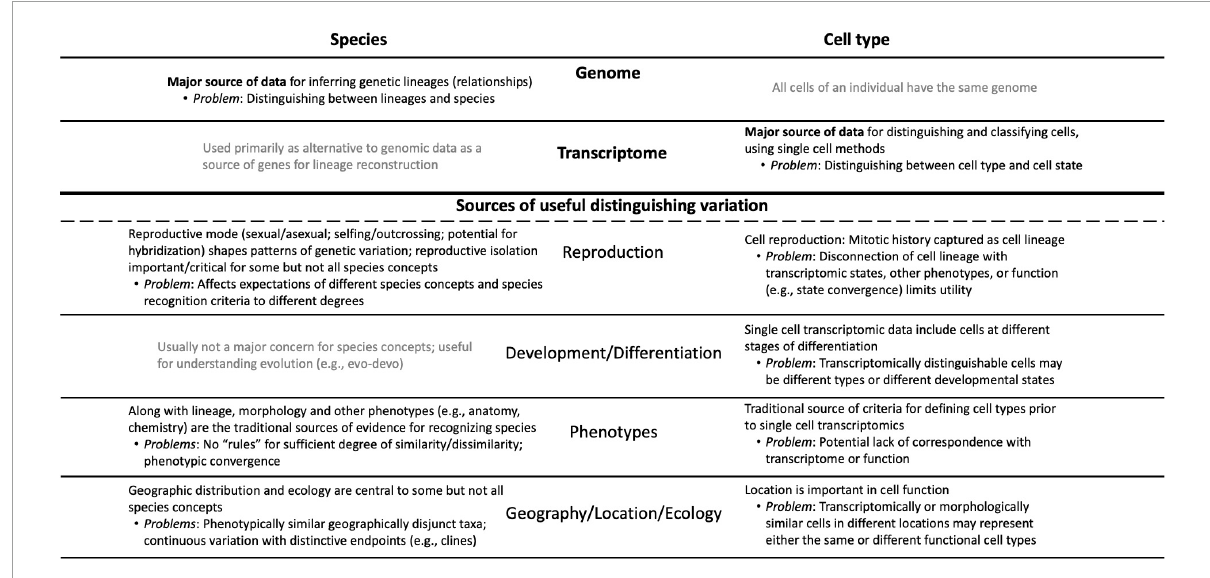
FIGURE1 Conceptual diagram showing the parallels and differences that characterize the “cell types as species” metaphor; it is designed both as an overview and as a complement to the sections of the essay. The major sources of relevant information are listed at the top of the diagram: genomic data for species vs. transcriptomic data for cell types. Below the heavy line are the sources of data that have (in black) or have not (in gray) been used by systematists in species concepts and their parallels in cell biology. The major problems associated with each data type and source of variation are